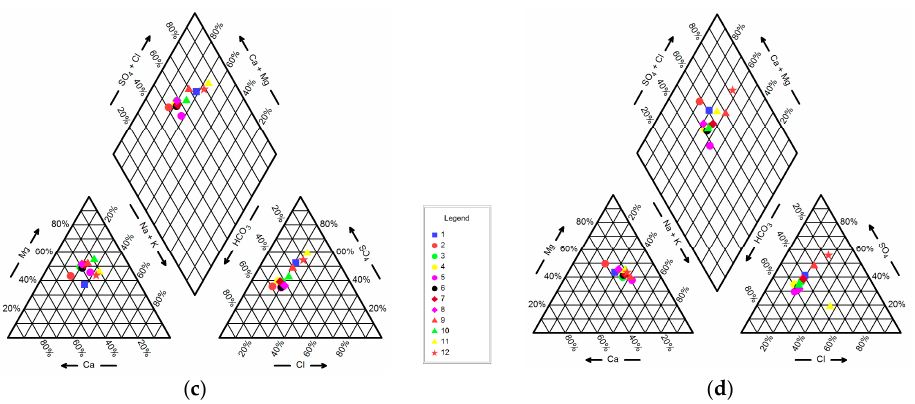
Figure 7. Piper diagram of groundwater quality for samples collected in ( a ) March 2014; ( b ) June 2014; ( c ) September 2014; and ( d ) November 2014.